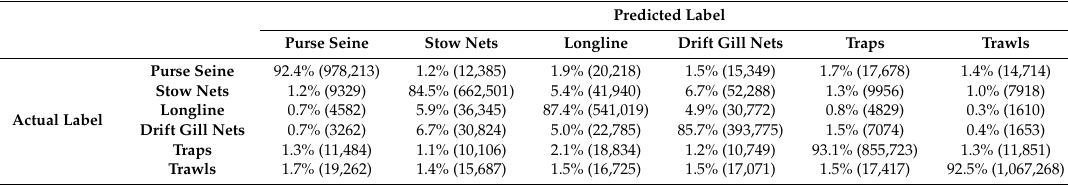
Table 7. Confusion matrix for the experiments of TPI.